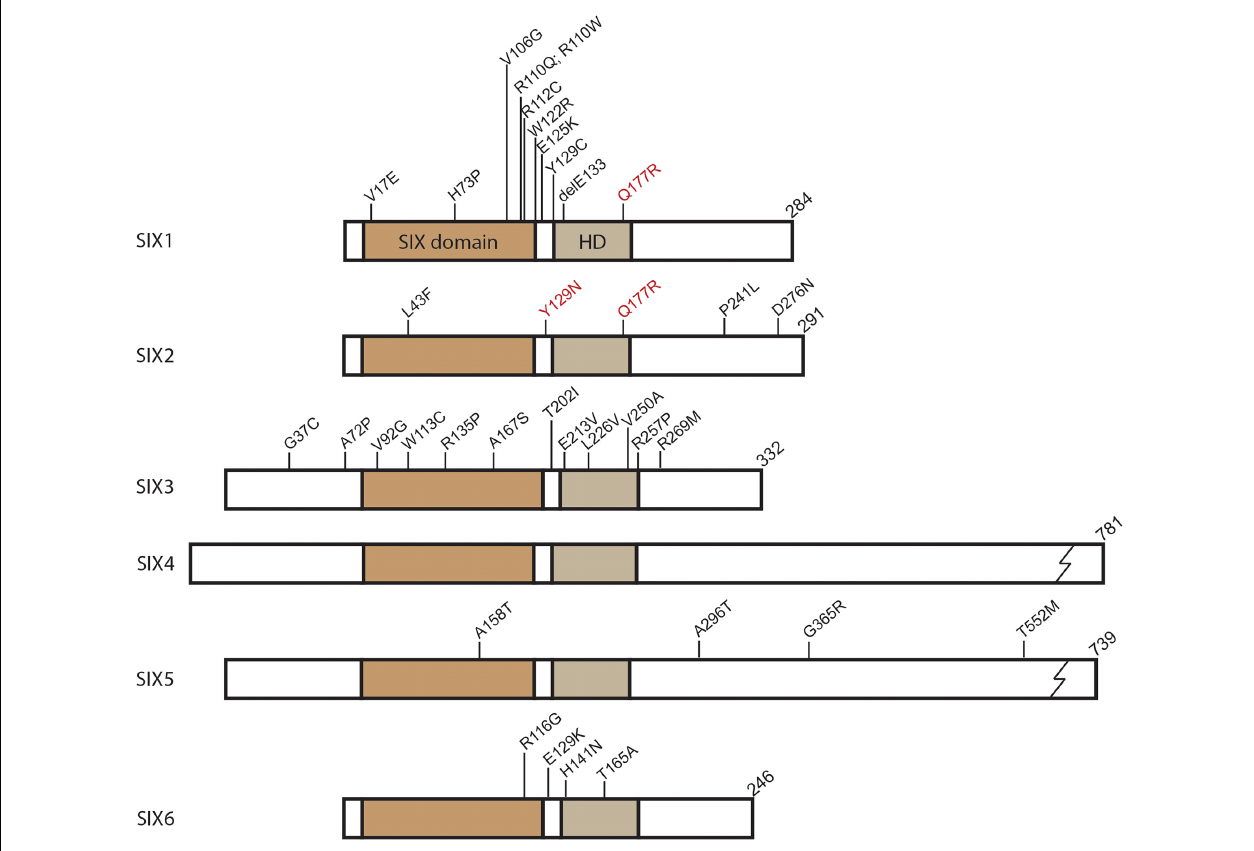
FIGURE 1 | SIX protein domain schematic and identified human mutations. Position of conserved domains shown for SIX domain and Homeodomain (HD). Mutations identified in SIX genes related to congenital conditions are labeled at their relative amino acid position. In addition to the mutations shown, single allele deletions have been identified for SIX2 , SIX3 , and SIX6 . SIX1 and SIX2 hyperactive mutations associated with Wilms tumor denoted in red. Common identified SIX3 mutations shown. For a complete list of SIX3 mutations identified in holoprosencephaly see Lacbawan et al.